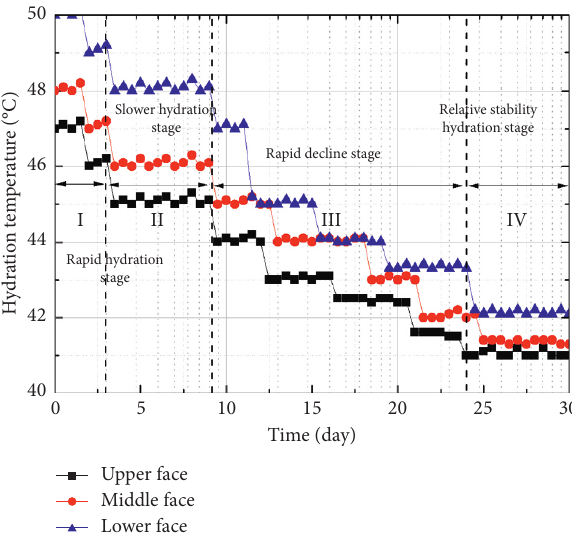
Figure 13: Temperature changes.